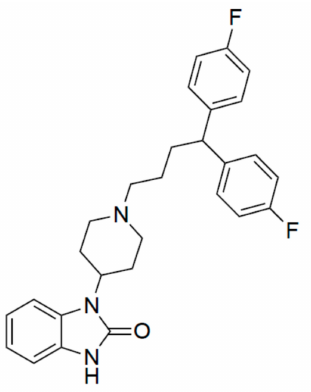
Figure 1. Structure of